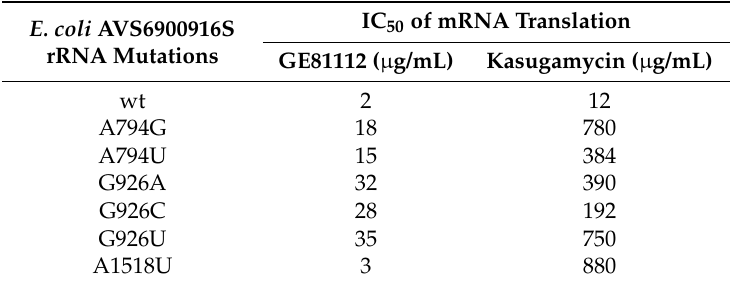
Table 5. Effect of 16S rRNA base substitutions on ribosome sensitivity to GE81112 and kasugamycin